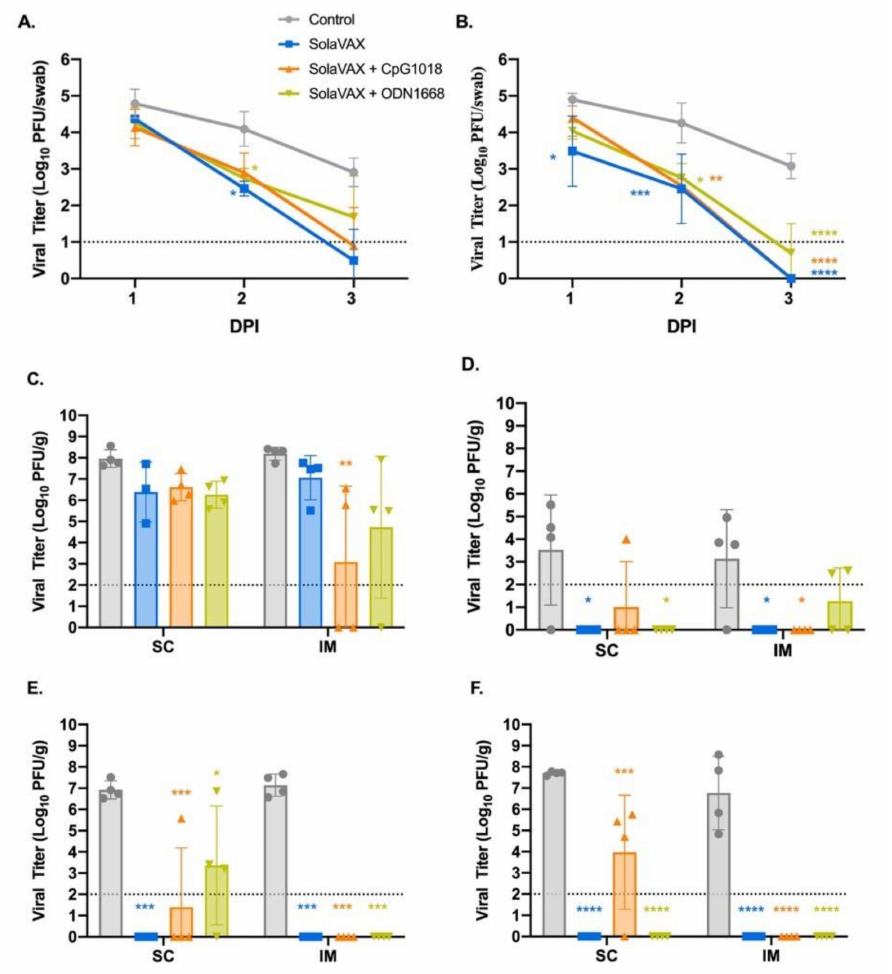
Figure 2. Viral loads from oropharyngeal swab and respiratory tract tissues after challenge with live virus. Oropharyngeal swabs were taken from all hamsters on 1, 2, and 3 days post infection (dpi). Viral titers of swabs collected from hamsters vaccinated via SC ( A ) and via IM ( B ) were determined by plaque assay. The presence of infectious virus was also determined in turbinates ( C ), trachea ( D ), right cranial lung lobe ( E ), and right caudal lung ( F ) of each hamster three days after live virus challenge. Data points represent group mean +/ − SD. SC, subcutaneous vaccination. IM, intramuscular vaccination. Asterisks above bars indicate statistically significant difference in viral titers between Control and vaccine group (**** p < 0.0001, *** p < 0.001, ** p < 0.01, * p < 0.05). Limit of detection denoted as horizontal dotted